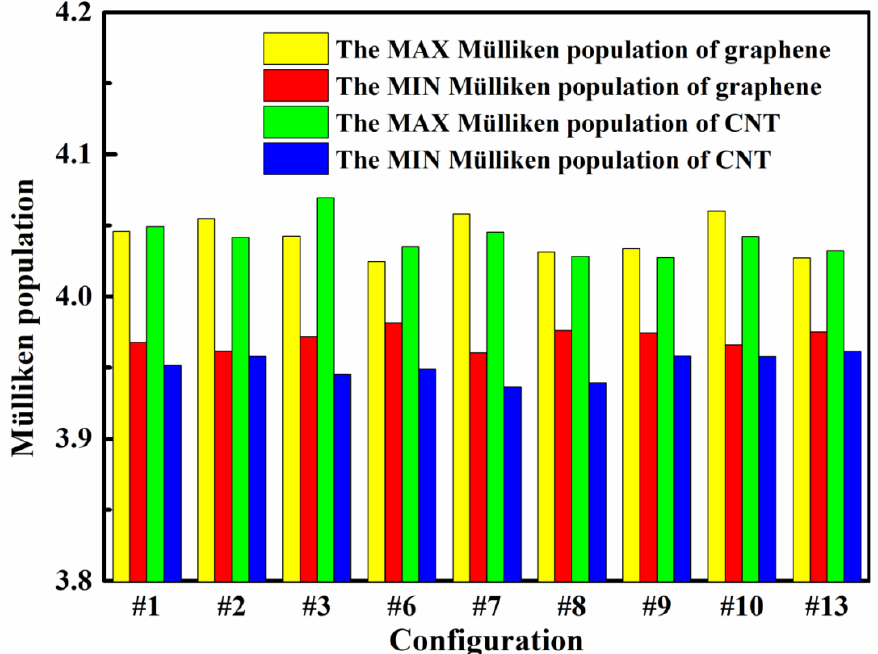
Figure 8. The Mülliken population both maximum and minimum of graphene and CNT in the (8,0)CNT-graphene.